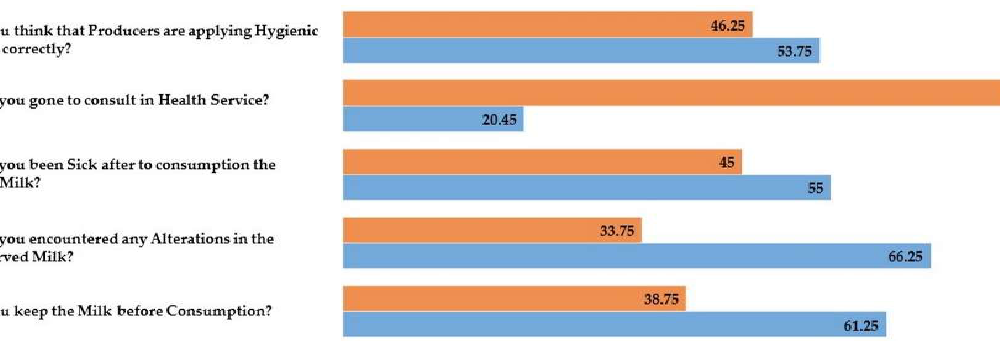
Figure 5. Practices of Consumer’s.